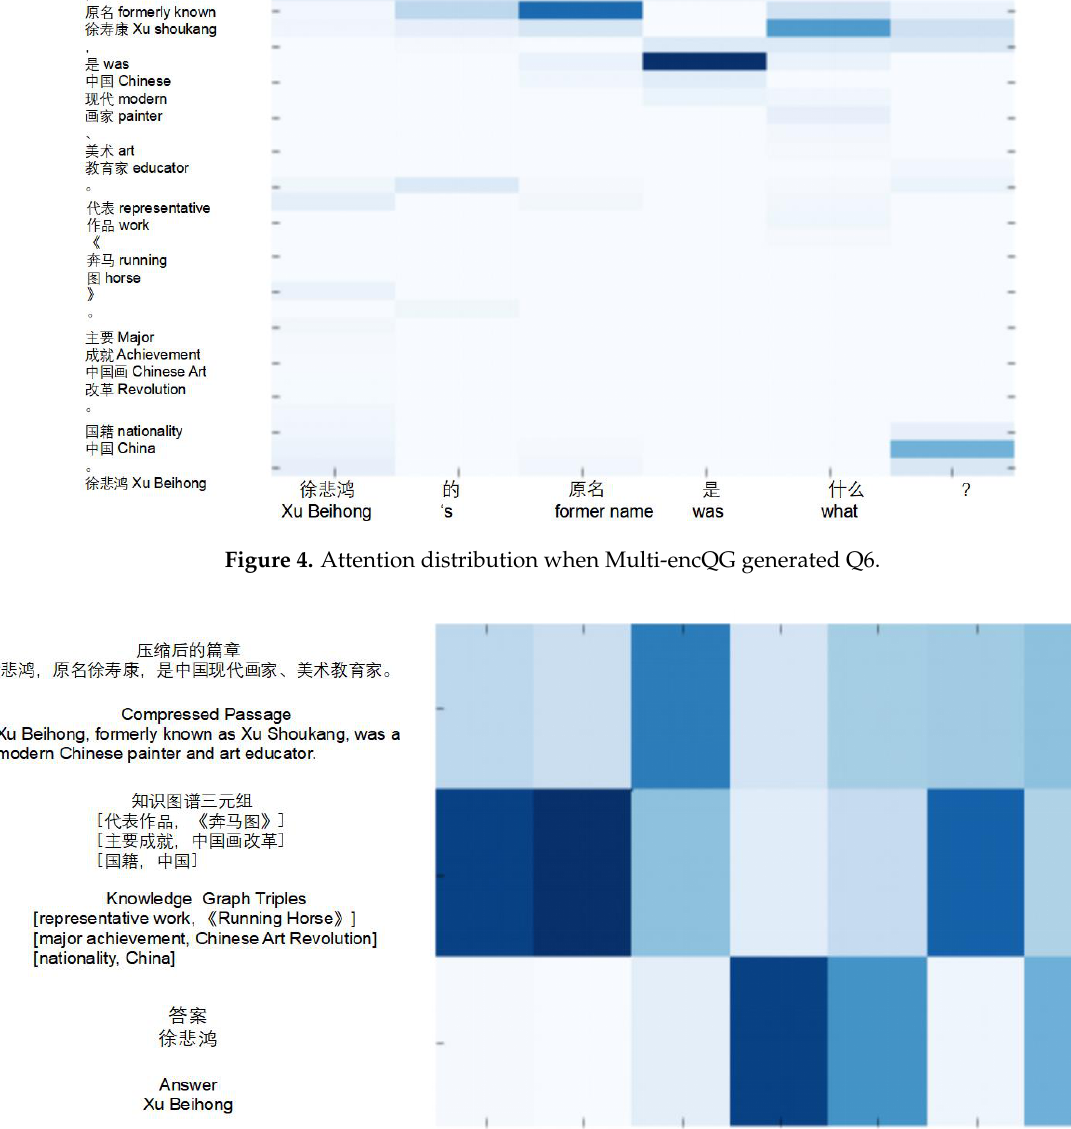
Figure 5. Global attention distribution when NQGKG++ generated question Q6.